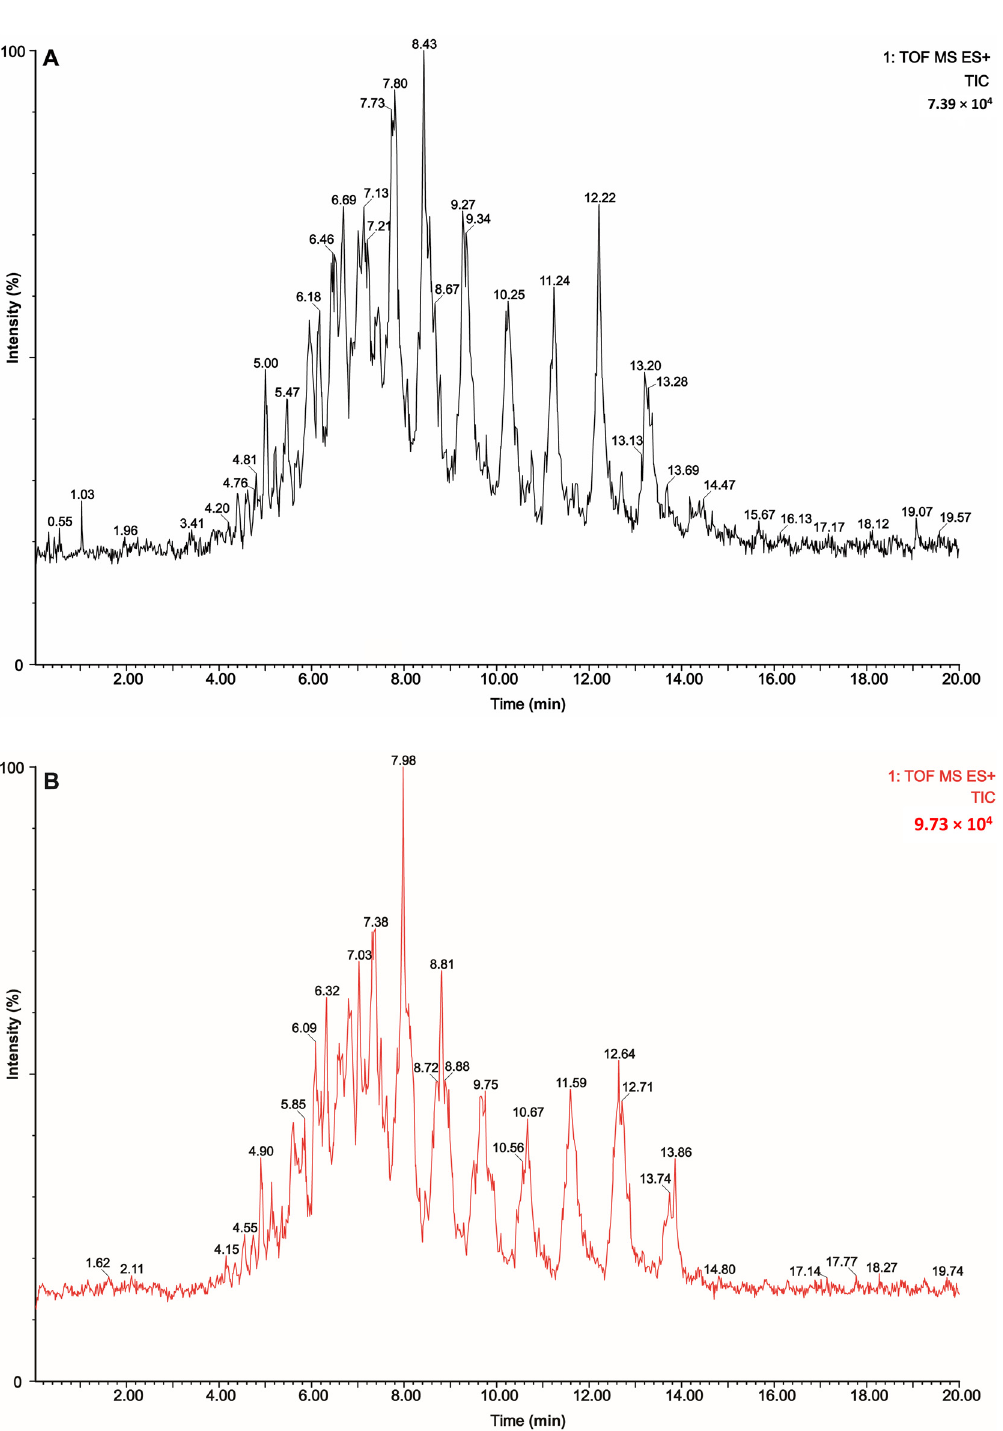
Figure 1. Total ion current chromatograms of TAGs in goat milk fat samples at a collision energy of 35 V analyzed by UPCC-Q-TOF-MS with supercritical carbon dioxide as a mobile phase under the positive ion (ESI + ) mode within 20 min: ( A ) Guanzhong goat milk, ( B ) Xinong Saanen goat milk. According to previous studies by Ruiz-Gutiérrez and Barron [57] and Mottram et al. [58], the elution cycle or the order of TAG molecular species in chromatographic methods was mostly related to the partition number (PN). The PN calculation for each TAG was described in previous publications as follows: PN = ACN − 2DB, where ACN is related to the acyl carbon number and DB to the double bonds number in esterified FAs at the glyc- erol molecule backbone. It was reported that TAGs with higher PN values showed longer